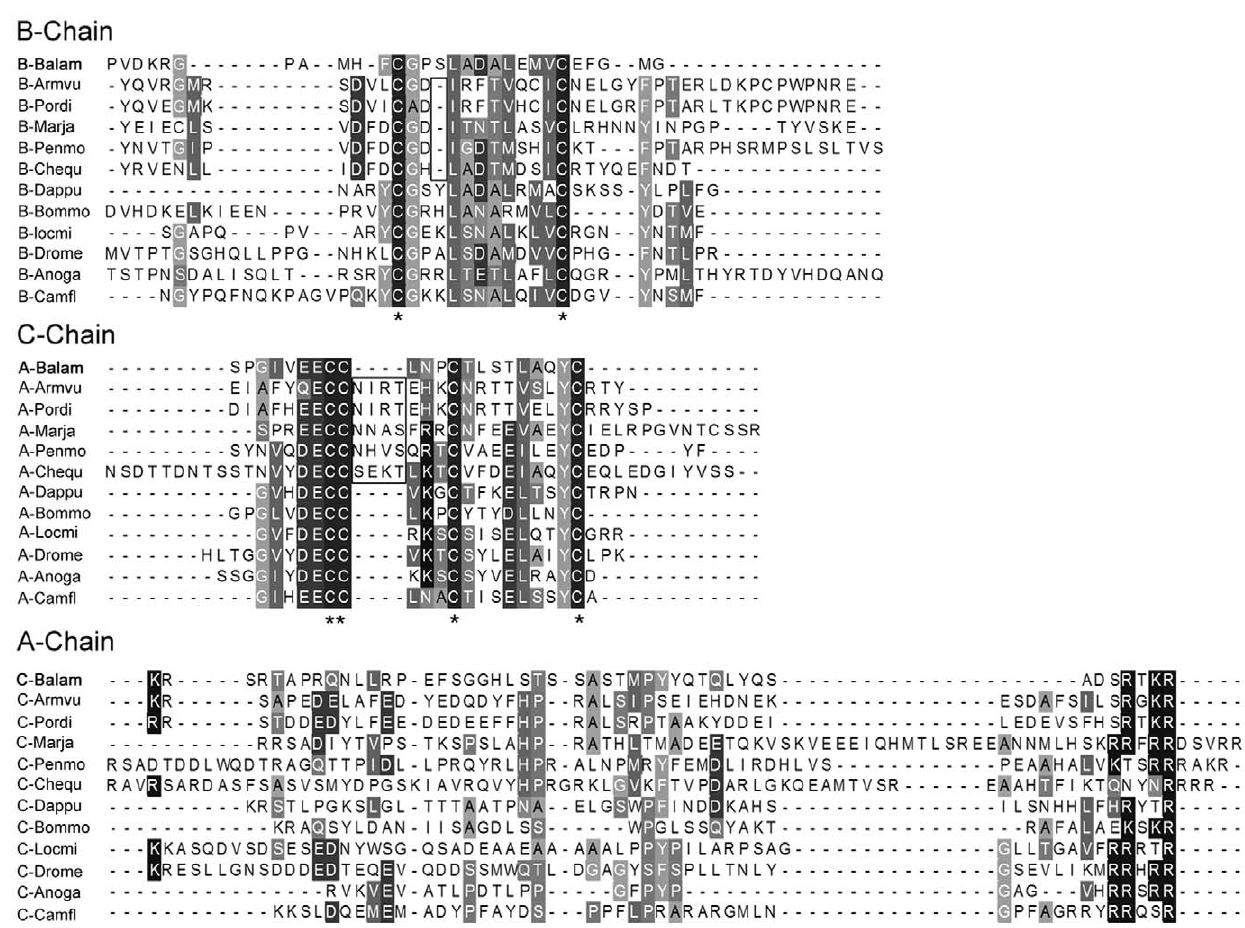
Figure 6. Peptide alignment of insulin-related peptide of Balanusamphitrite with arthropods. Isopods IRP are from: Armadillidium vulgare AB029615 and Porcellio dilatatus AB089811; decapods IRP are from: Marsupenaeus japonicus AB029615, Penaeus monodon GU208677.1 and Cherax quadricarinatus DQ851163; branchiopod IRP is from Daphnia pulex [38]; insects IRP are from: Bombyx mori NP_001233285, Locusta migratoria P15131, Drosophila melanogaster CG14173, Anopheles gambiae AAQ89693 and Camponotus floridanus EFN61735. Asterisks ‘‘*’’ mark the conserved Cysteine residues, black frame indicates specific amino acids insertion and deletion in IRP of isopod and decapod species, compared to insects, branchiopod and barnacle.